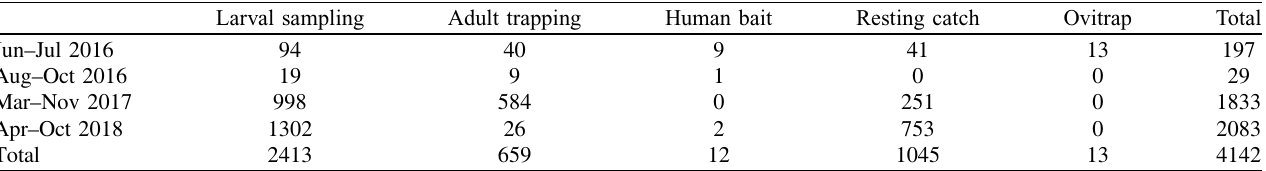
Table 3. Sampling effort of the surveys, according to period and sampling method.